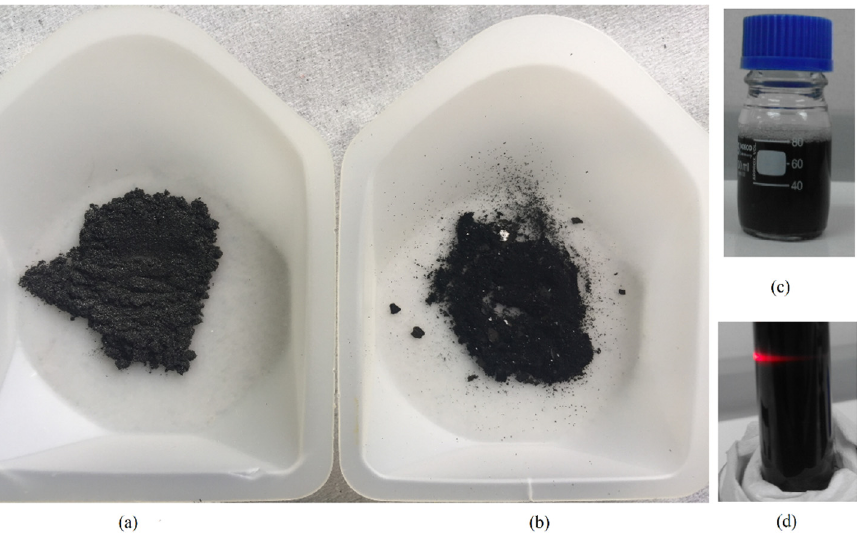
Figure 1. ( a ) Graphite powder, ( b ) graphene, ( c ) represents 80 mL of homogeneous graphene dispersion, and ( d ) exhibiting the Tyndall effect when a red laser beam is passed through it, indicating the formation of a uniform dispersion.